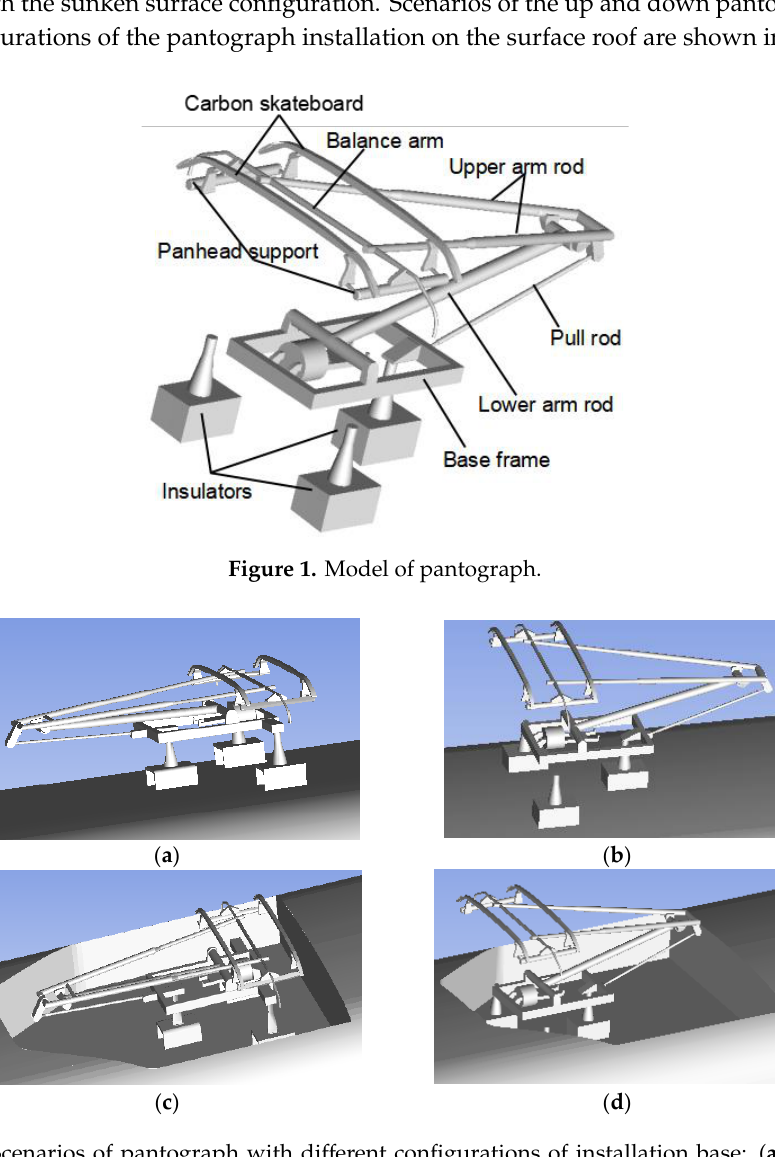
Figure 2. Scenarios of pantograph with different configurations of installation base: ( a ) model of down-pantograph with flush installation; ( b ) model of up-pantograph with flush installation; ( c ) model of down-pantograph with sunken installation; and ( d ) model of up-pantograph with sunken installation.